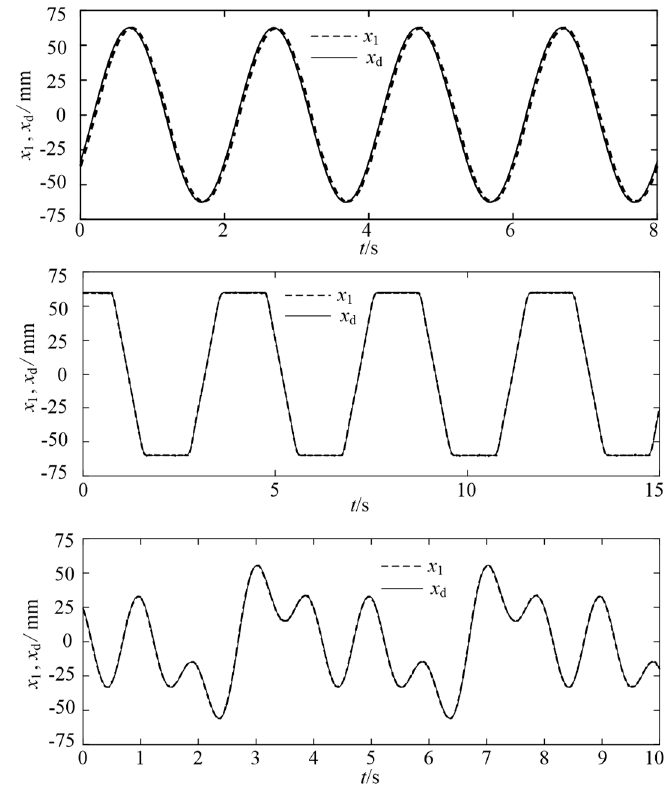
Figure 5. Tracking response of the proposed controller for three different types of trajectories.